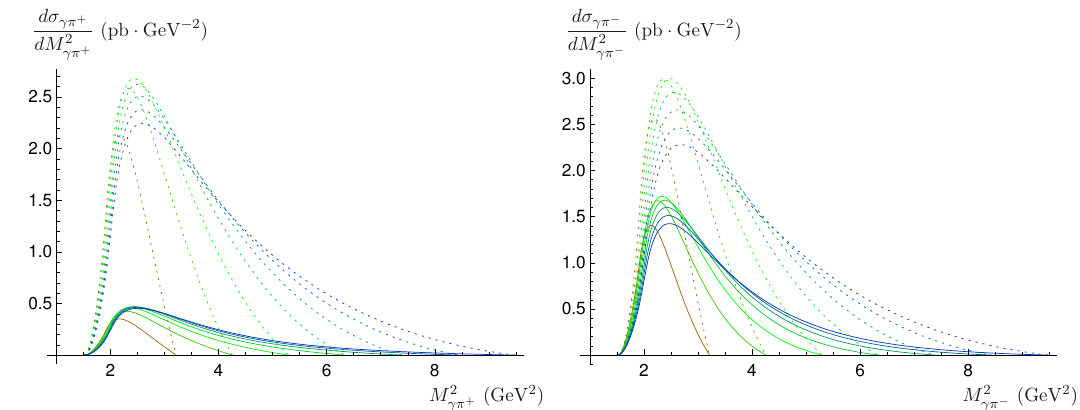
Figure 6 . Left: differential cross section dσ/dM 2 for the production of a photon and a π + meson γπ + on a proton target. Right: differential cross section dσ/dM 2 for the production of a photon and γπ − a π − meson on a neutron target. The values of S γN vary in the set 8, 10, 12, 14, 16, 18, 20 GeV 2 . (from 8: left, brown to 20: right, blue), covering the JLab energy range. We use here the “valence”(solid) and the “standard“ (dotted)